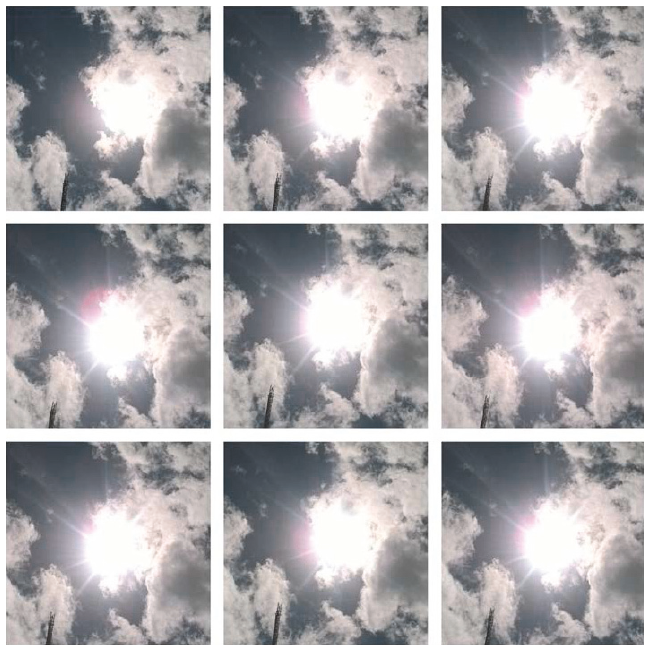
Figure 2: Typical con fi guration of the sky that can lead to a solar radiation enhancement e ff